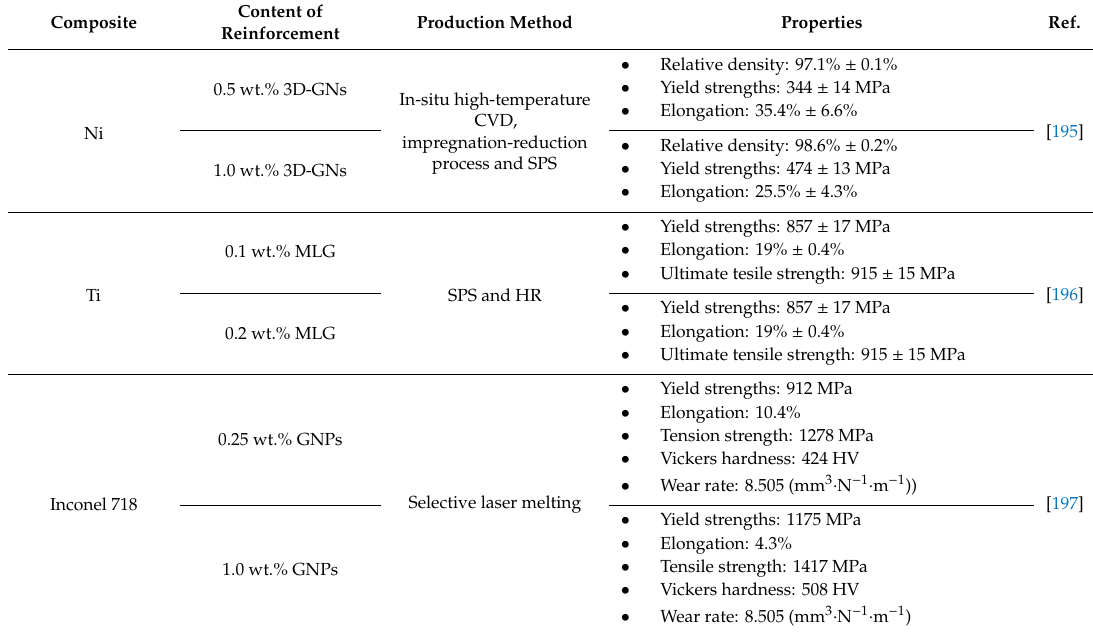
Table 9. A review of the characteristics of graphene-reinforced metal matrix